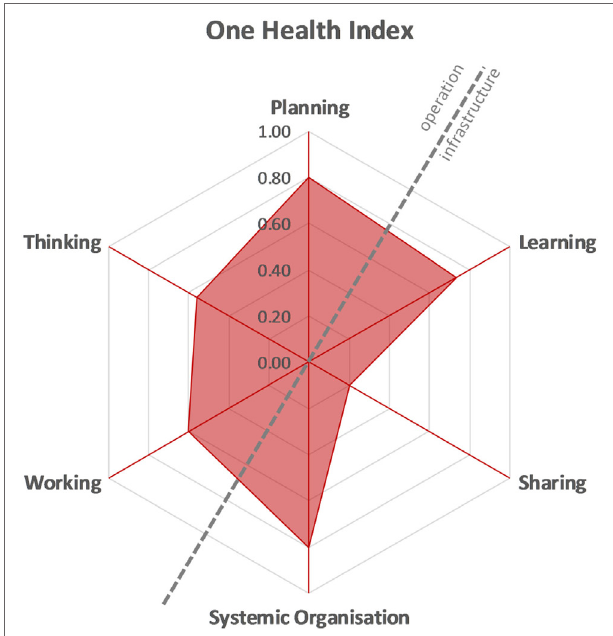
FigUre 12 | One Health Index of the Southern African Centre for Infectious Disease